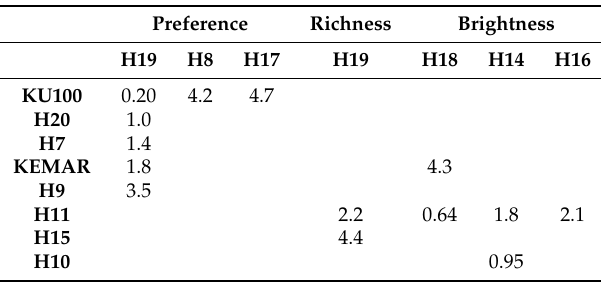
Table 5. Significant differences found between individual stimuli with respect to preference, richness and brightness attributes. The values shown are the p -values (%) from a post hoc pairwise mean comparison test using Tukey’s Honestly Significant Difference procedure. A value below 5% was considered significant. The stimuli shown vertically received a higher rating in each case.